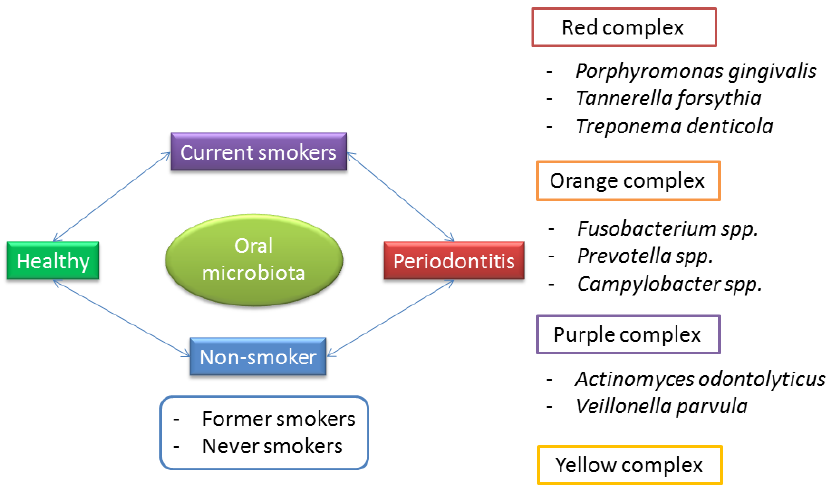
Figure 1. The interplay between smoke and the microbiota on the composition of the oral microbiota in the pathogenesis of periodontitis.